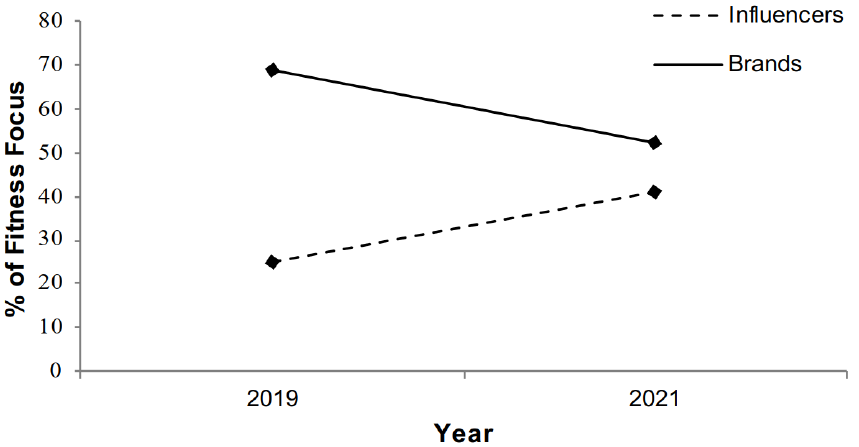
Figure 1. Changes in Fitness Focus by Account Type and